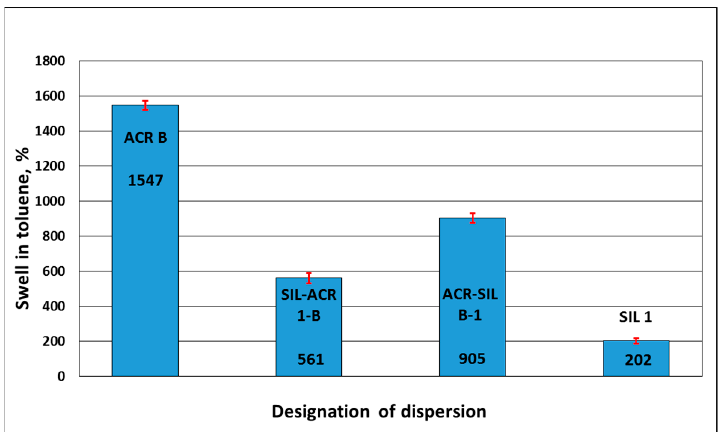
Figure 13. Comparison of % swell in toluene determined for starting silicone resin dispersion (SIL-1), starting acrylic/styrene copolymer dispersion (ACR B) and hybrid dispersions ACR-SIL B-1 and SIL-ACR 1-B having the same composition of SIL and ACR parts.